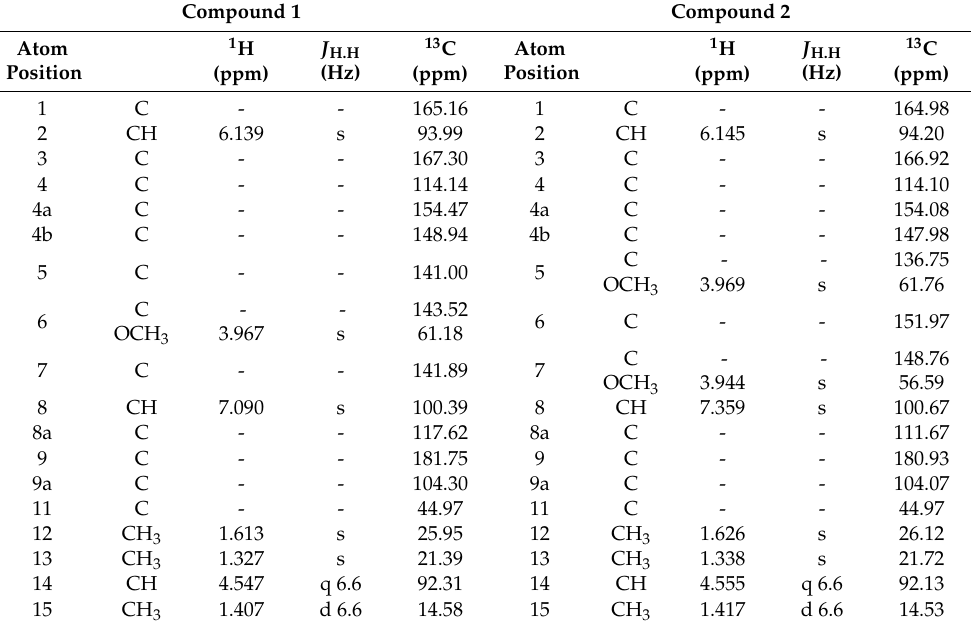
Table 2. 1 H- and 13 C-NMR data of compound 1 and 2 in CD 3